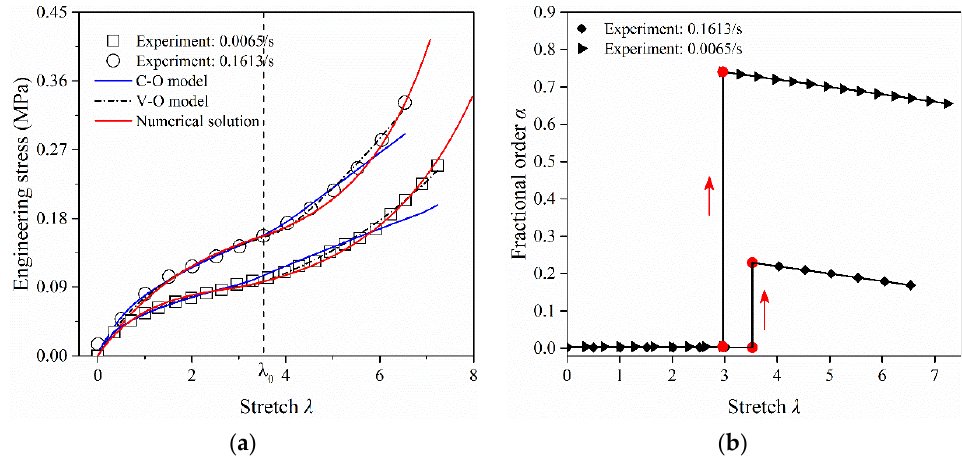
Figure 6. ( a ) Comparison of the simulated results of different fractional models and the experimental data at stretch rates of 0.0065/s and 0.1613/s; ( b ) Derived order variance of the presented numerical stress response. (Experimental data were taken from [51]). Table 3. Derived model parameters of constant-order (CO) fractional model. Model Parameters